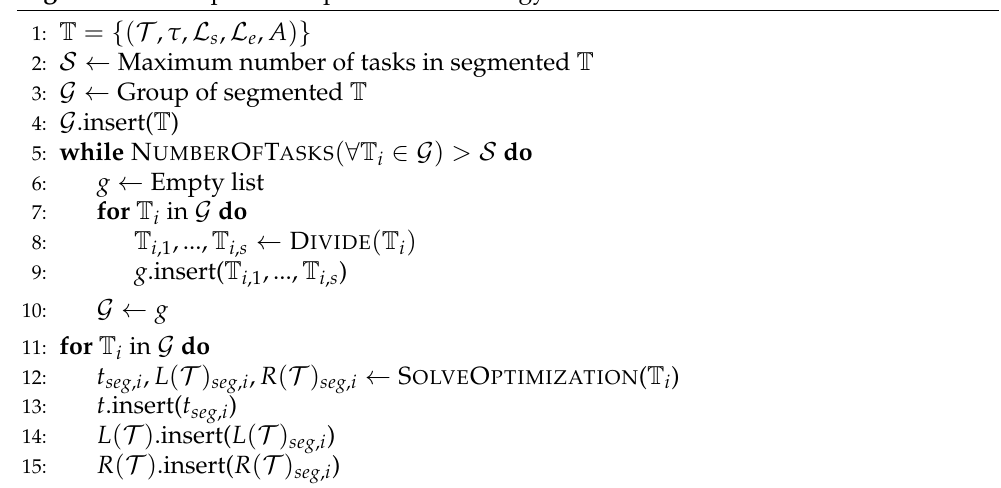
Algorithm 3: Subproblem optimization strategy.